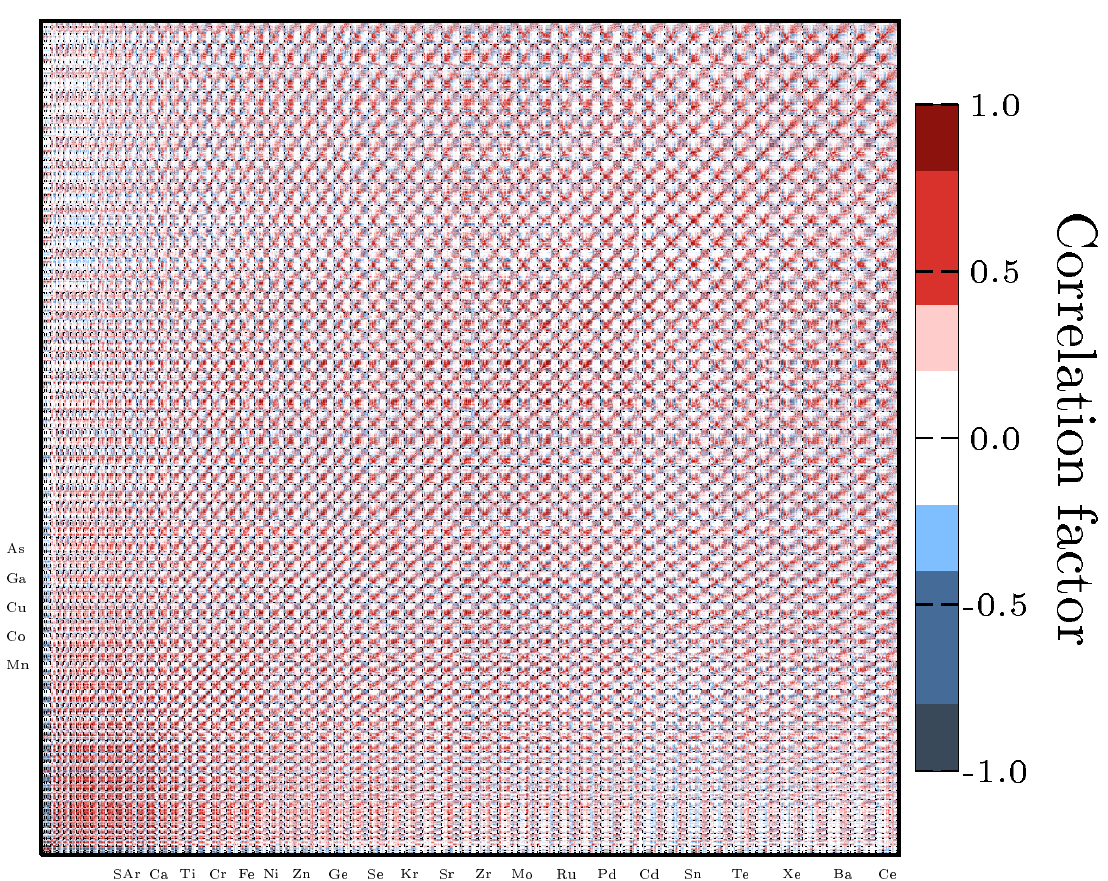
Figure 5: Correlation between nuclei for the MACS at 30 keV, taking into account 288 variations of models. Each element, included in one box, is presented with increasing